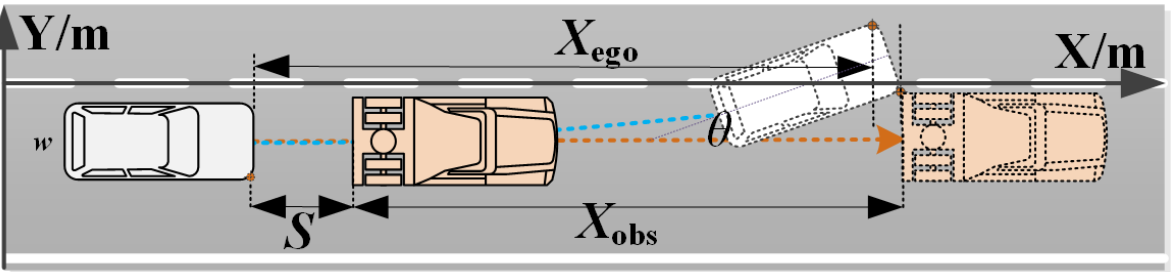
Figure 4. Schematic diagram of vehicle obstacle avoidance process.